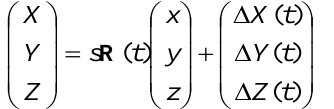
Figure 1. SPOT-5 stereo pair over Daejeon, Korea